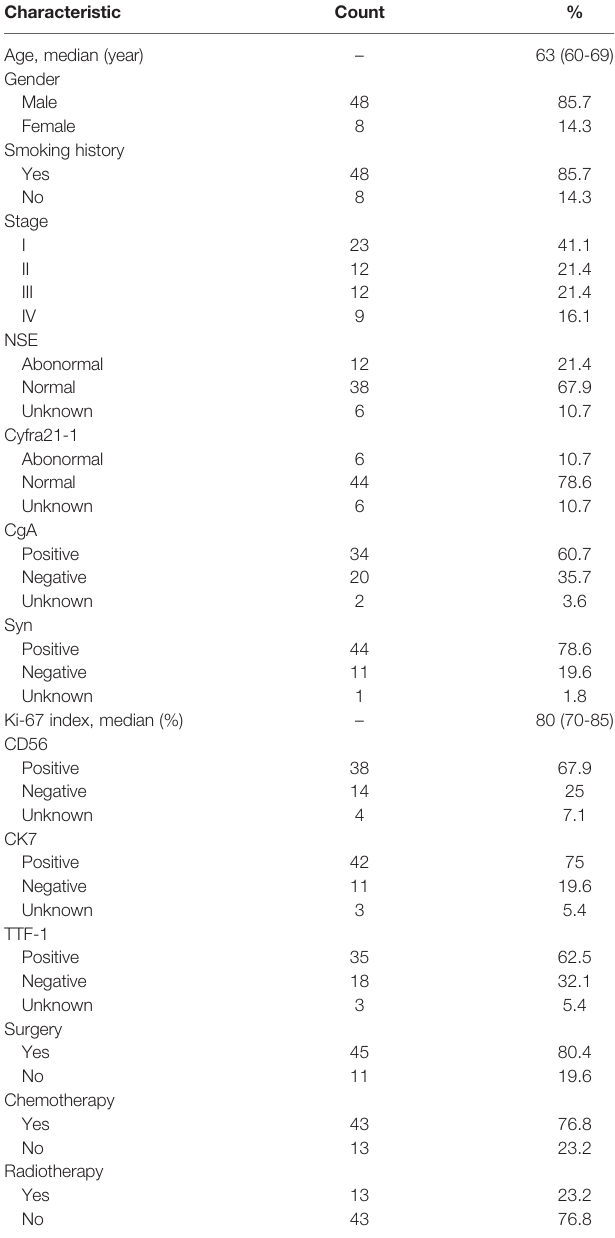
TABLE 1 | Clinical characteristics of patients with pulmonary large cell neuroendocrine carcinoma from the PUMCH cohort. Characteristic Count